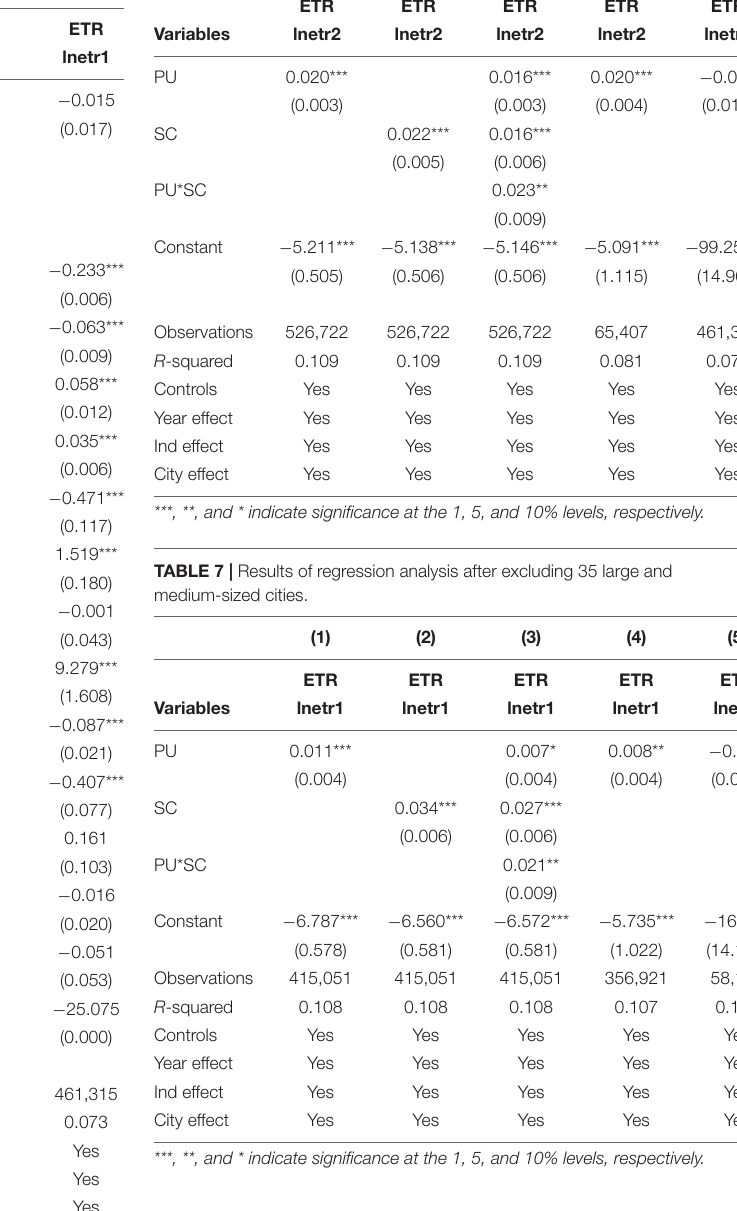
TABLE 5 | Interaction of official change and official social capital on effective corporate tax rate.